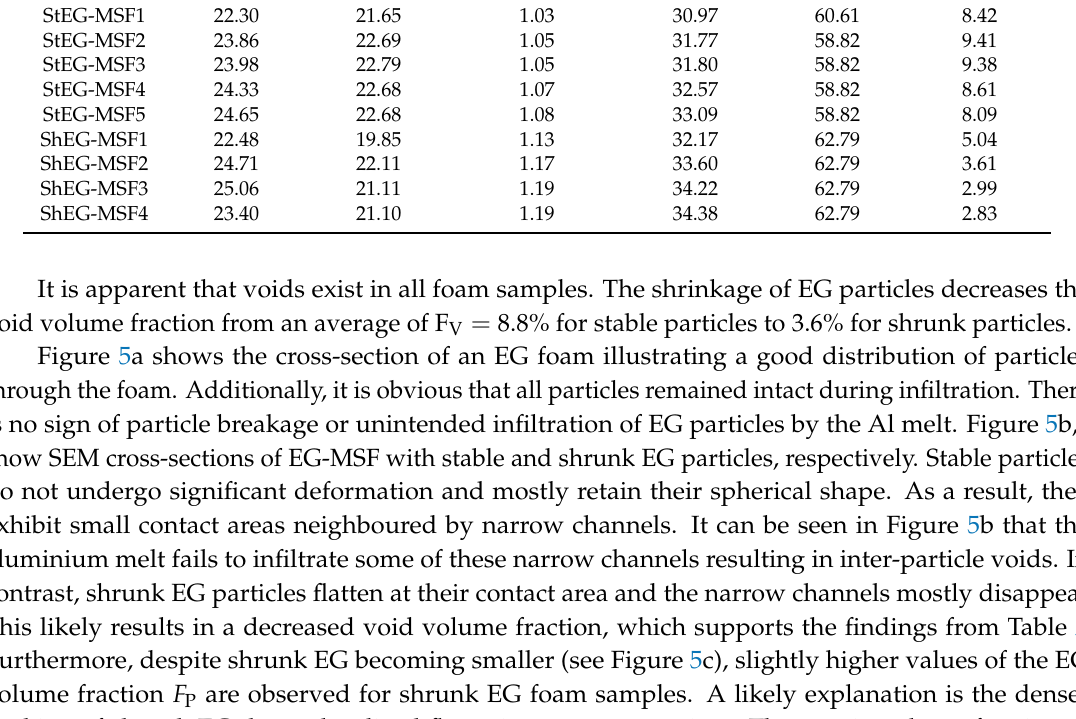
Table 2. Physical properties of EG-MSF samples (St and Sh mean stable and shrunk EG, respectively).